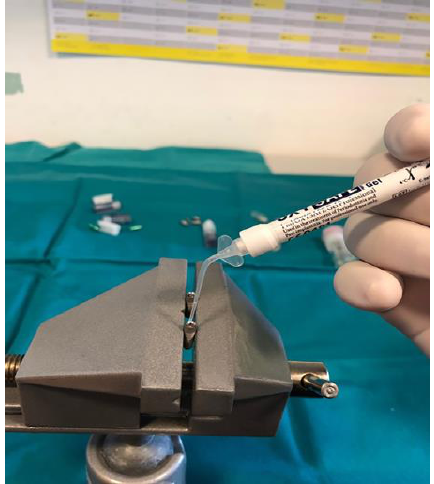
Figure 3. GapSeal gel application.